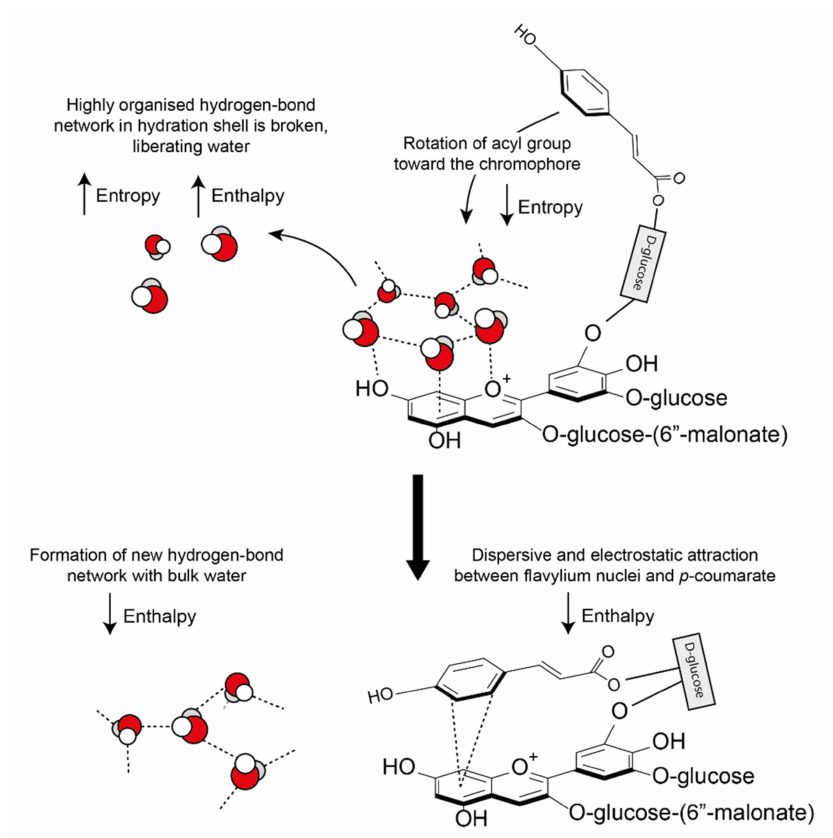
Figure 16. Classical and non-classical hydrophobic forces involved in the formation of co- pigmentation complexes. As the two interacting aromatics approach each other, hydrogen bonds between the highly organised hydration shell are broken, increasing both enthalpy and entropy. New hydrogen bonds form between the displaced water molecules and the bulk water, decreasing enthalpy. A further decrease in enthalpy is observed due to the formation of attractive dispersive and electrostatic interactions. All observed co-pigmentation interactions are exothermic ( − ∆ H) and spontaneous ( − ∆ G0) at room temperature (23 ◦